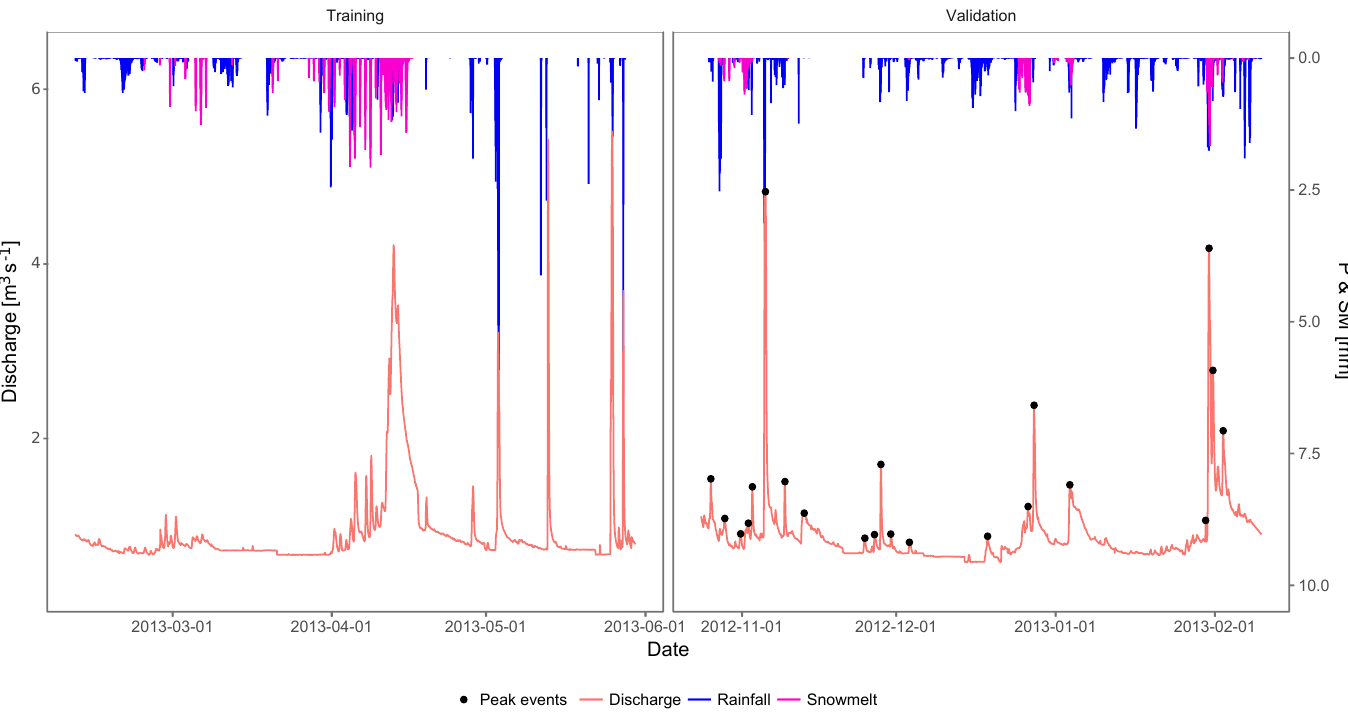
Figure 1. Training and validation time series of discharge (red), rainfall (blue) and snowmelt (pink) in 1 h resolution. The peak events used for error calculation are indicated with black dots. P stands for rainfall and SM stands for snowmelt on the right-hand side vertical